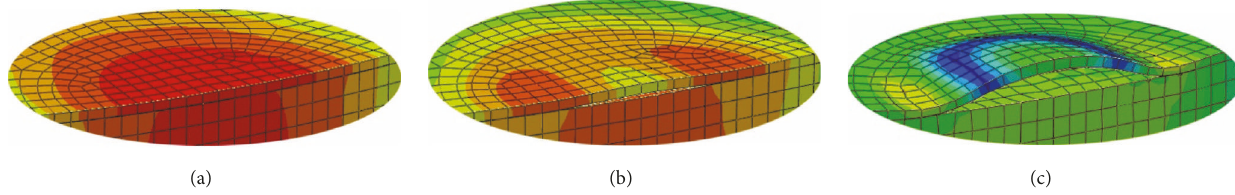
Figure 5: Spatial behaviour of contacting surfaces: (a) full contact or closing; (b) partial contact; and (c) no contact or opening.